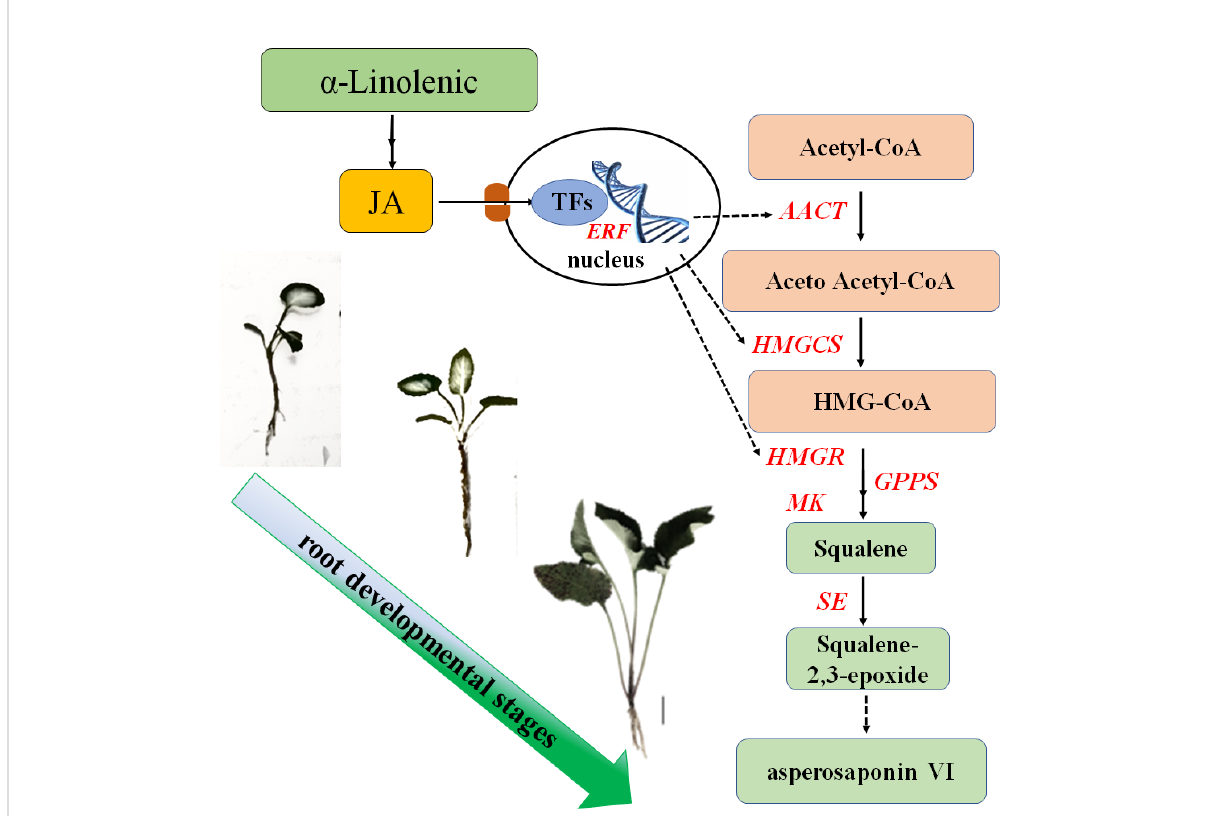
FIGURE 8 Schematic showing the role of a -linolenic acid and JA in the biosynthesis of asperosaponin VI during the root deveopmental in D. asperoides.